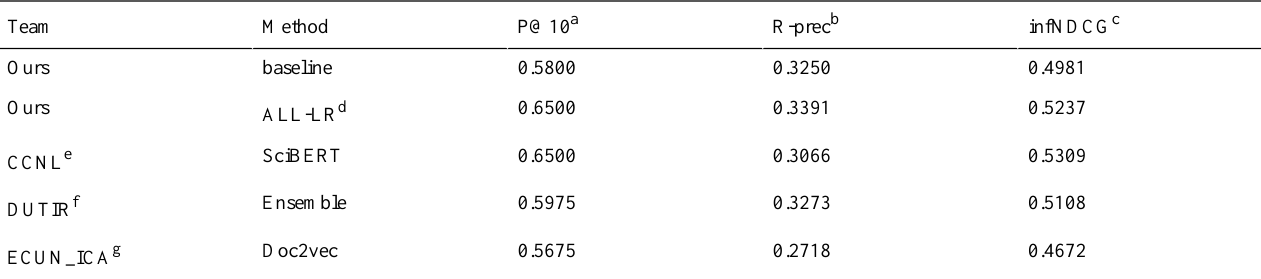
Table 5. Performance comparison of various